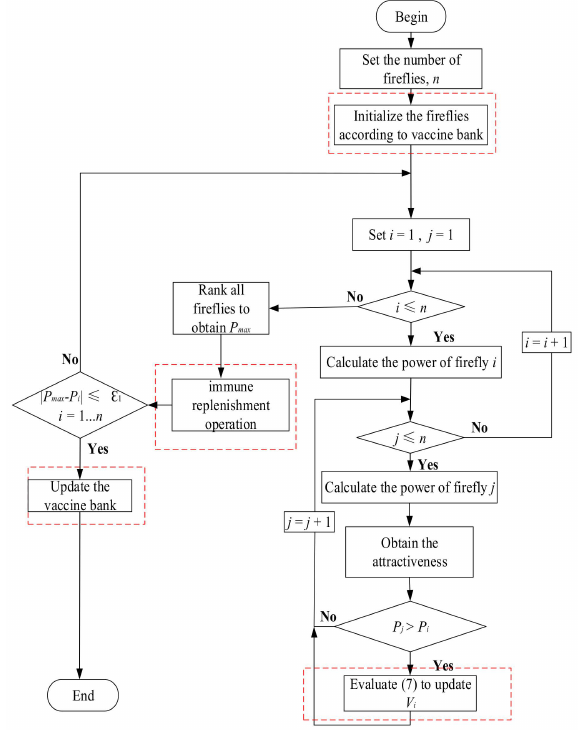
Figure 4. Flow chart of immune firefly algorithm